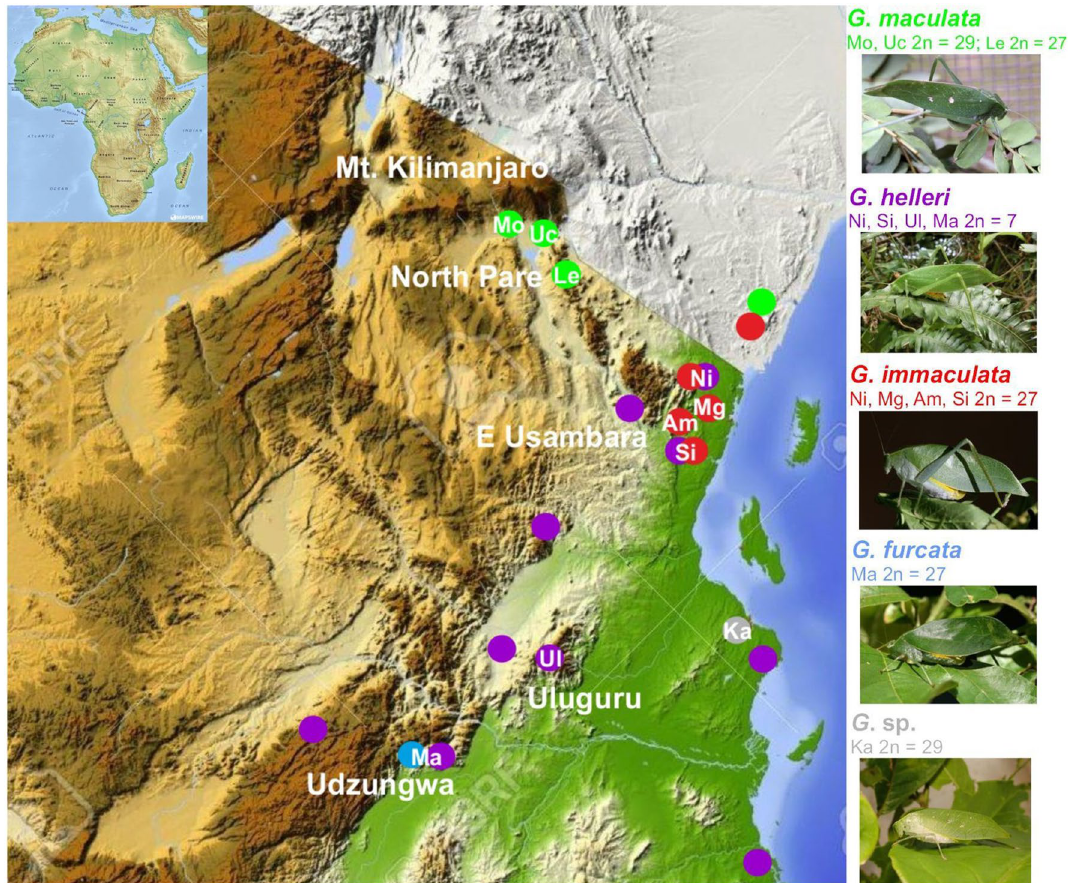
Figure 1. Map of geographical distribution and so far known localities (empty circles) and sampling points for Gonatoxia populations in East Africa. Each locality has a color key according to the species name (right side). Photos C. Hemp. Abbreviations in circles are given in Table S1. Diploid chromosome numbers (2n) and localities for species are plotted near the name of the species. The map was made using Google map [https:// www. 123rf. com/ photo_ 11687 795_ tanza nia- shaded- relief- map- surro unding- terri tory- greyed- out- color ed- accor ding- to- eleva tion- inclu des-. html (Projection: Mercator Extents: 28.3/41.5/-12.7/0 Data source: NASA)] and created by E.